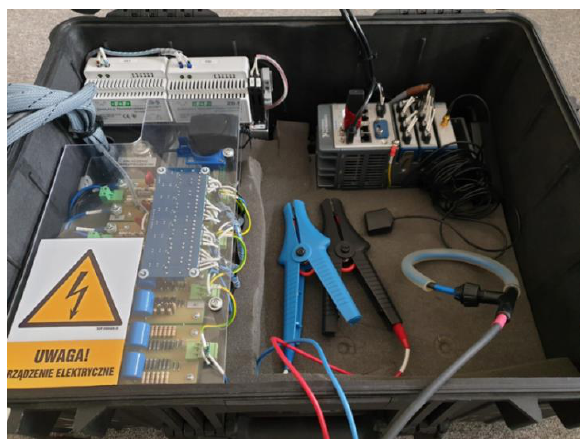
Figure 6. View of 1 MHz voltage and current recorder components. Table 1. Specification of the hardware components of the laboratory test circuits. Programmable AC Source/Kikusui PCR500LA